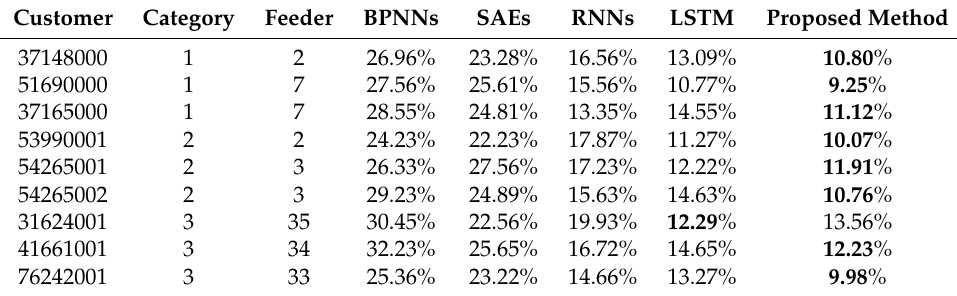
Table 11. MAPEs of compared methods for nine customers’ short-term load forecasting on 30 November 2013.